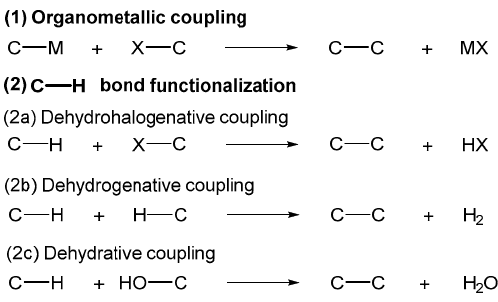
Figure 2. Representative examples of biologically active α , β